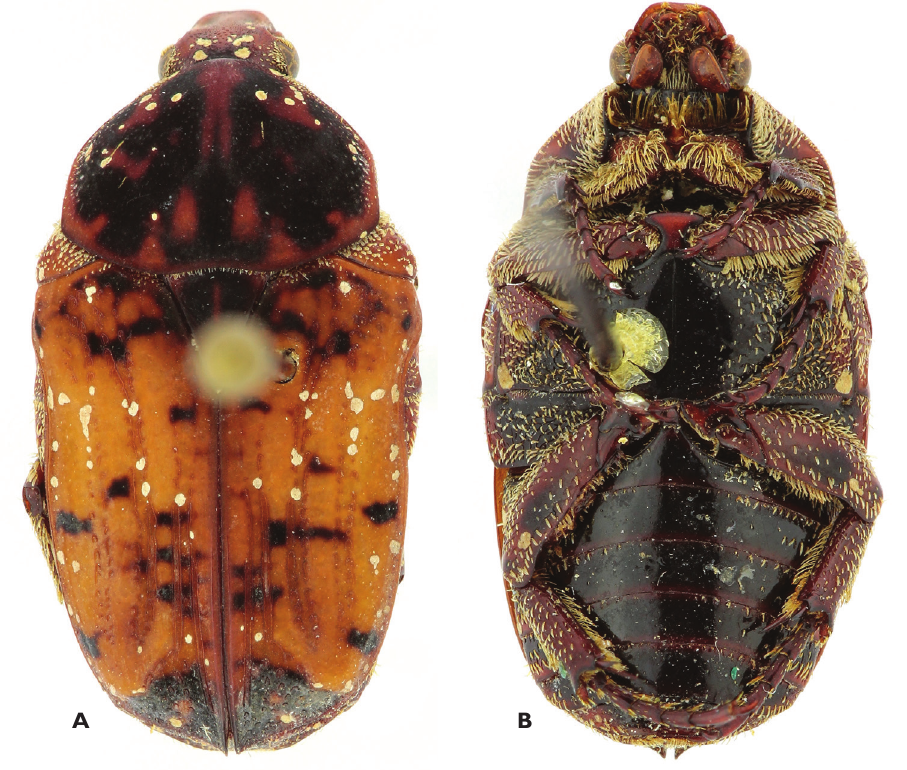
Figure 8. Atrichelaphinis ( Eugeaphinis ) deplanata deplanata (Moser, 1907), holotype (MNHU). A Dorsal view B ventral